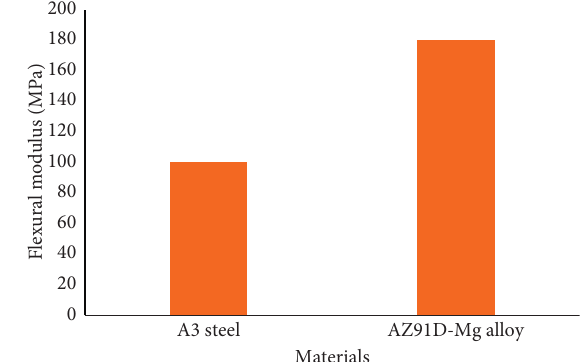
Figure 13: Flexural modulus for both materials.